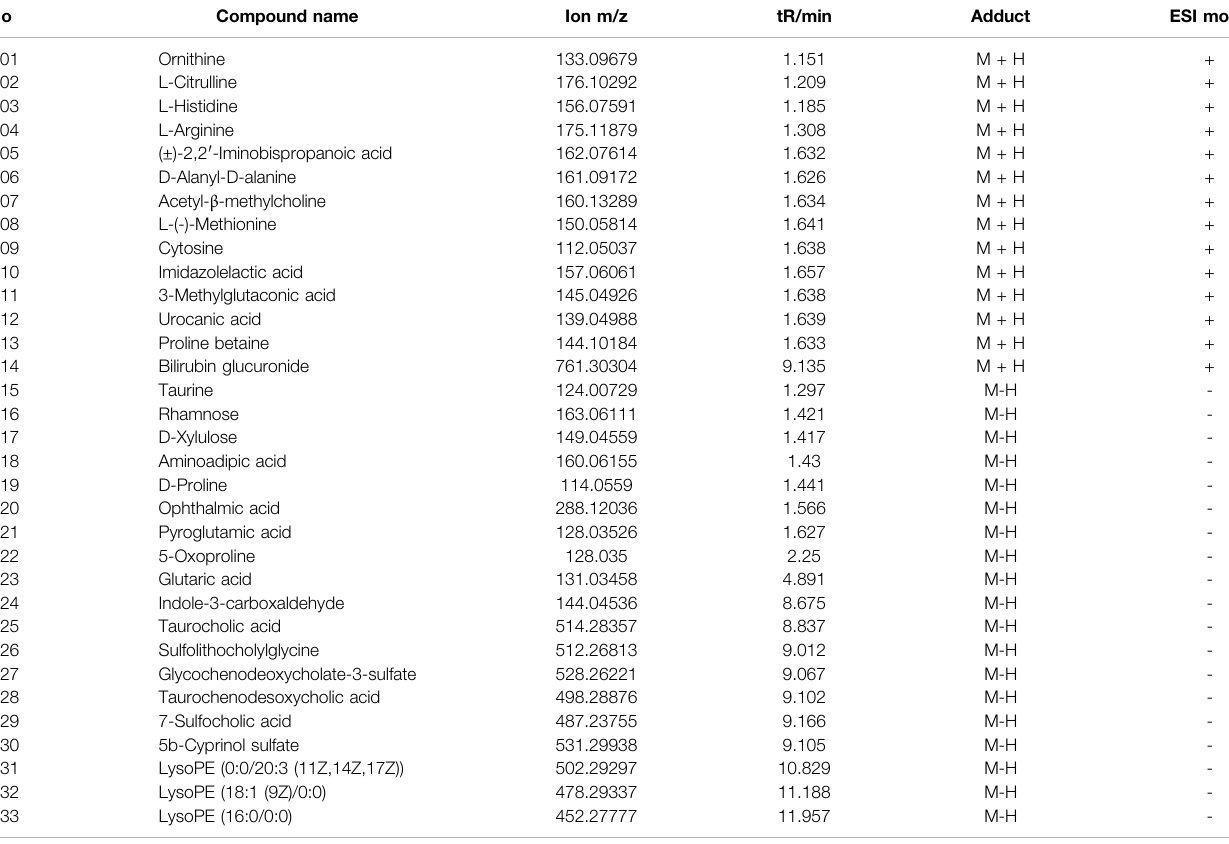
TABLE 2 | Thirty-three potential biomarkers in serum samples of mice.